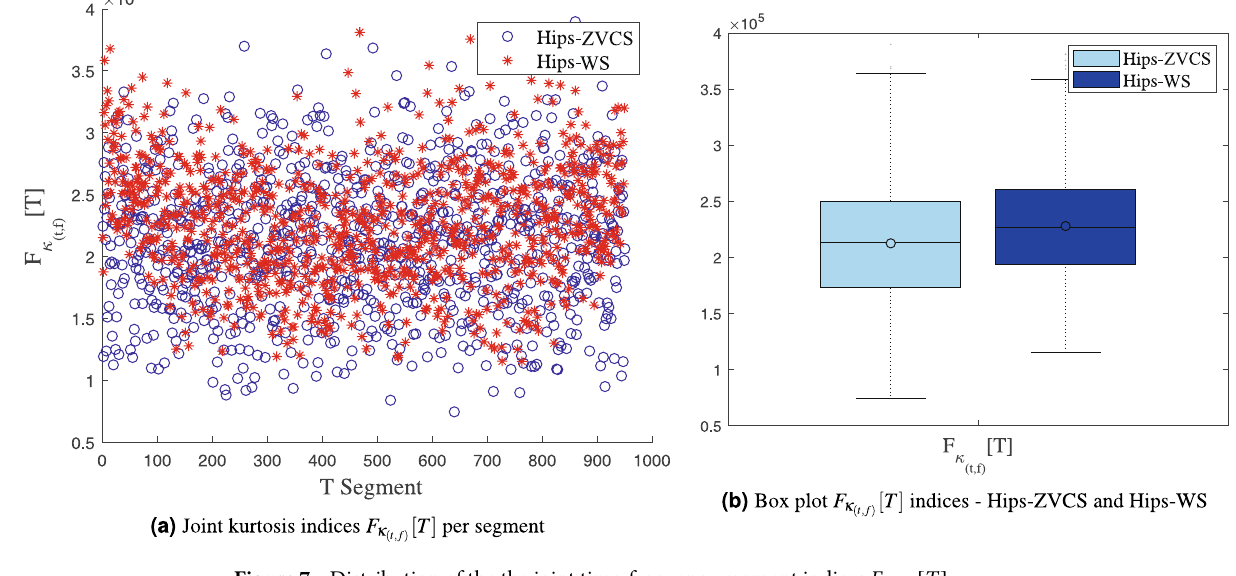
Figure 7. Distribution of the the joint time-frequency moment indices F κ